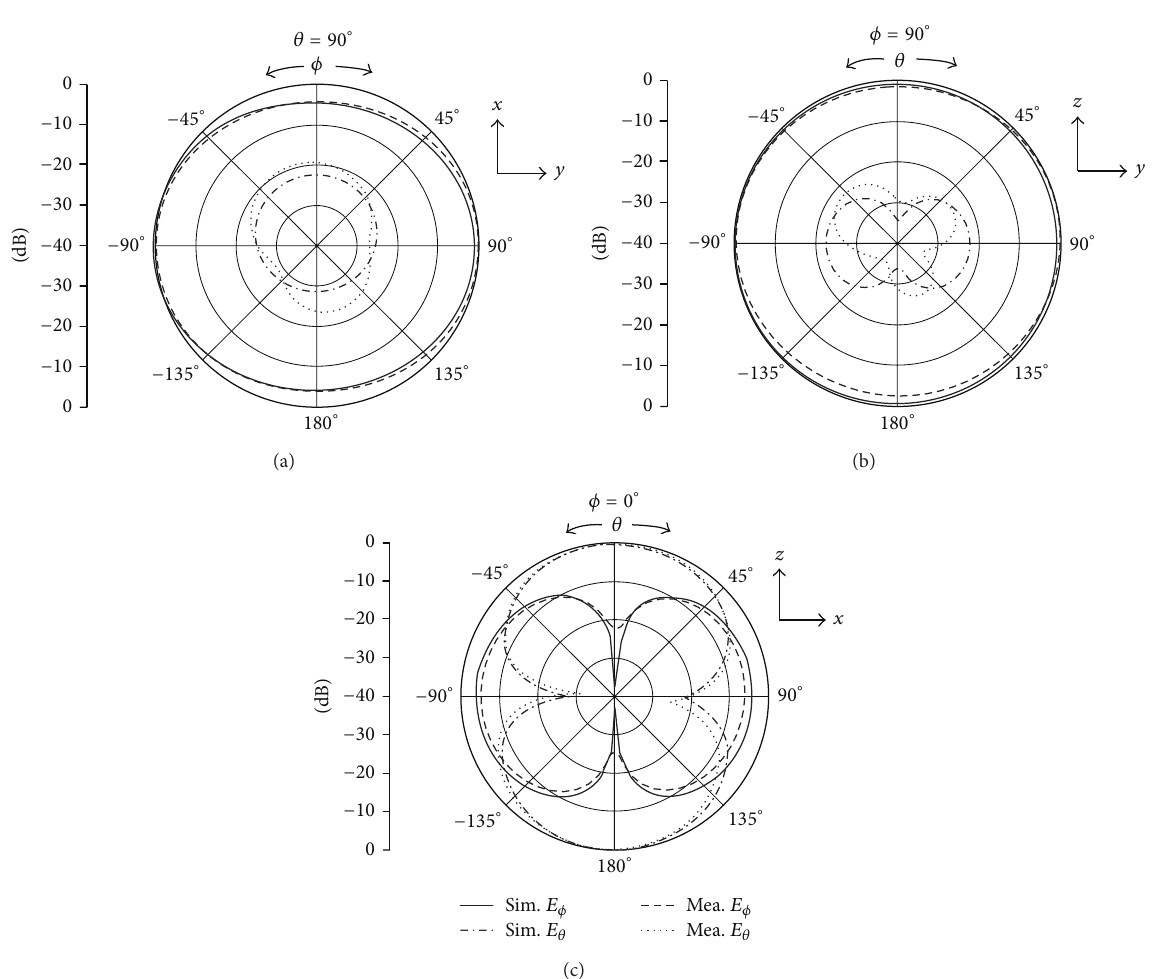
Figure 6: Radiation patterns at 920 MHz in the (a) 𝑥 - 𝑦 plane, (b) 𝑦 - 𝑧 plane, and (c) 𝑥 - 𝑧